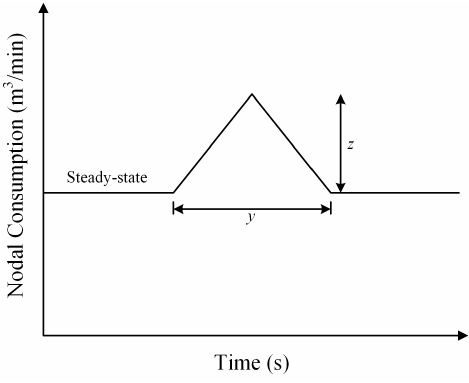
Figure 2. Transient excitation at operation point.